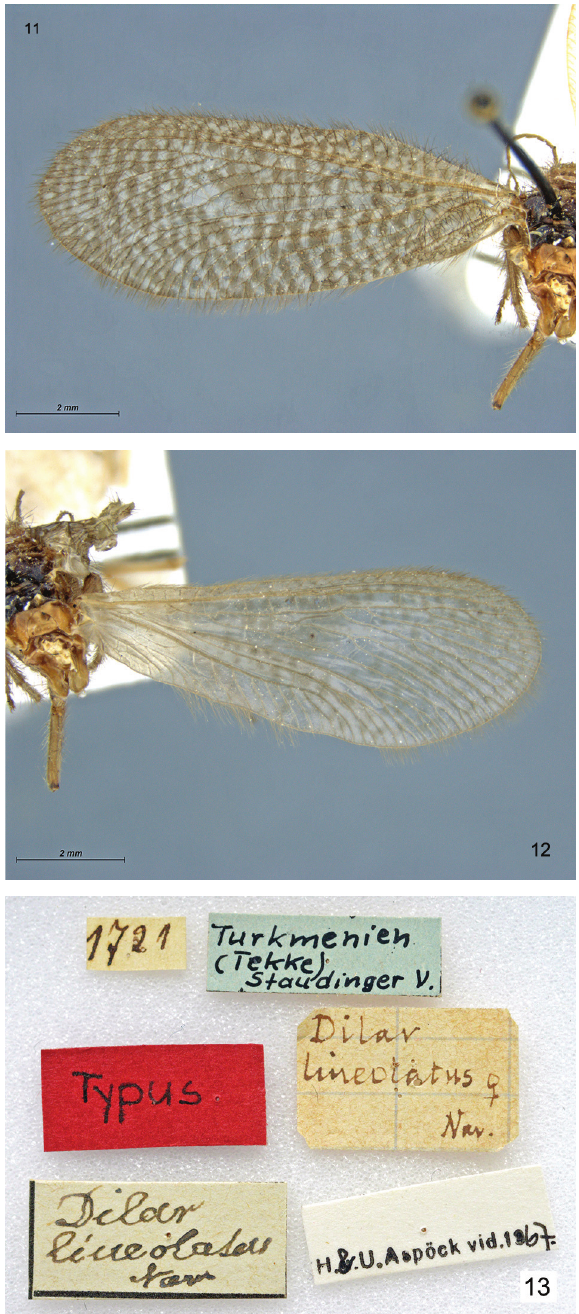
Figures 11–13. Dilar lineolatus Navás, holotype, female (MFN, Berlin). 11. Left forewing; 12. Right hindwing; 13.